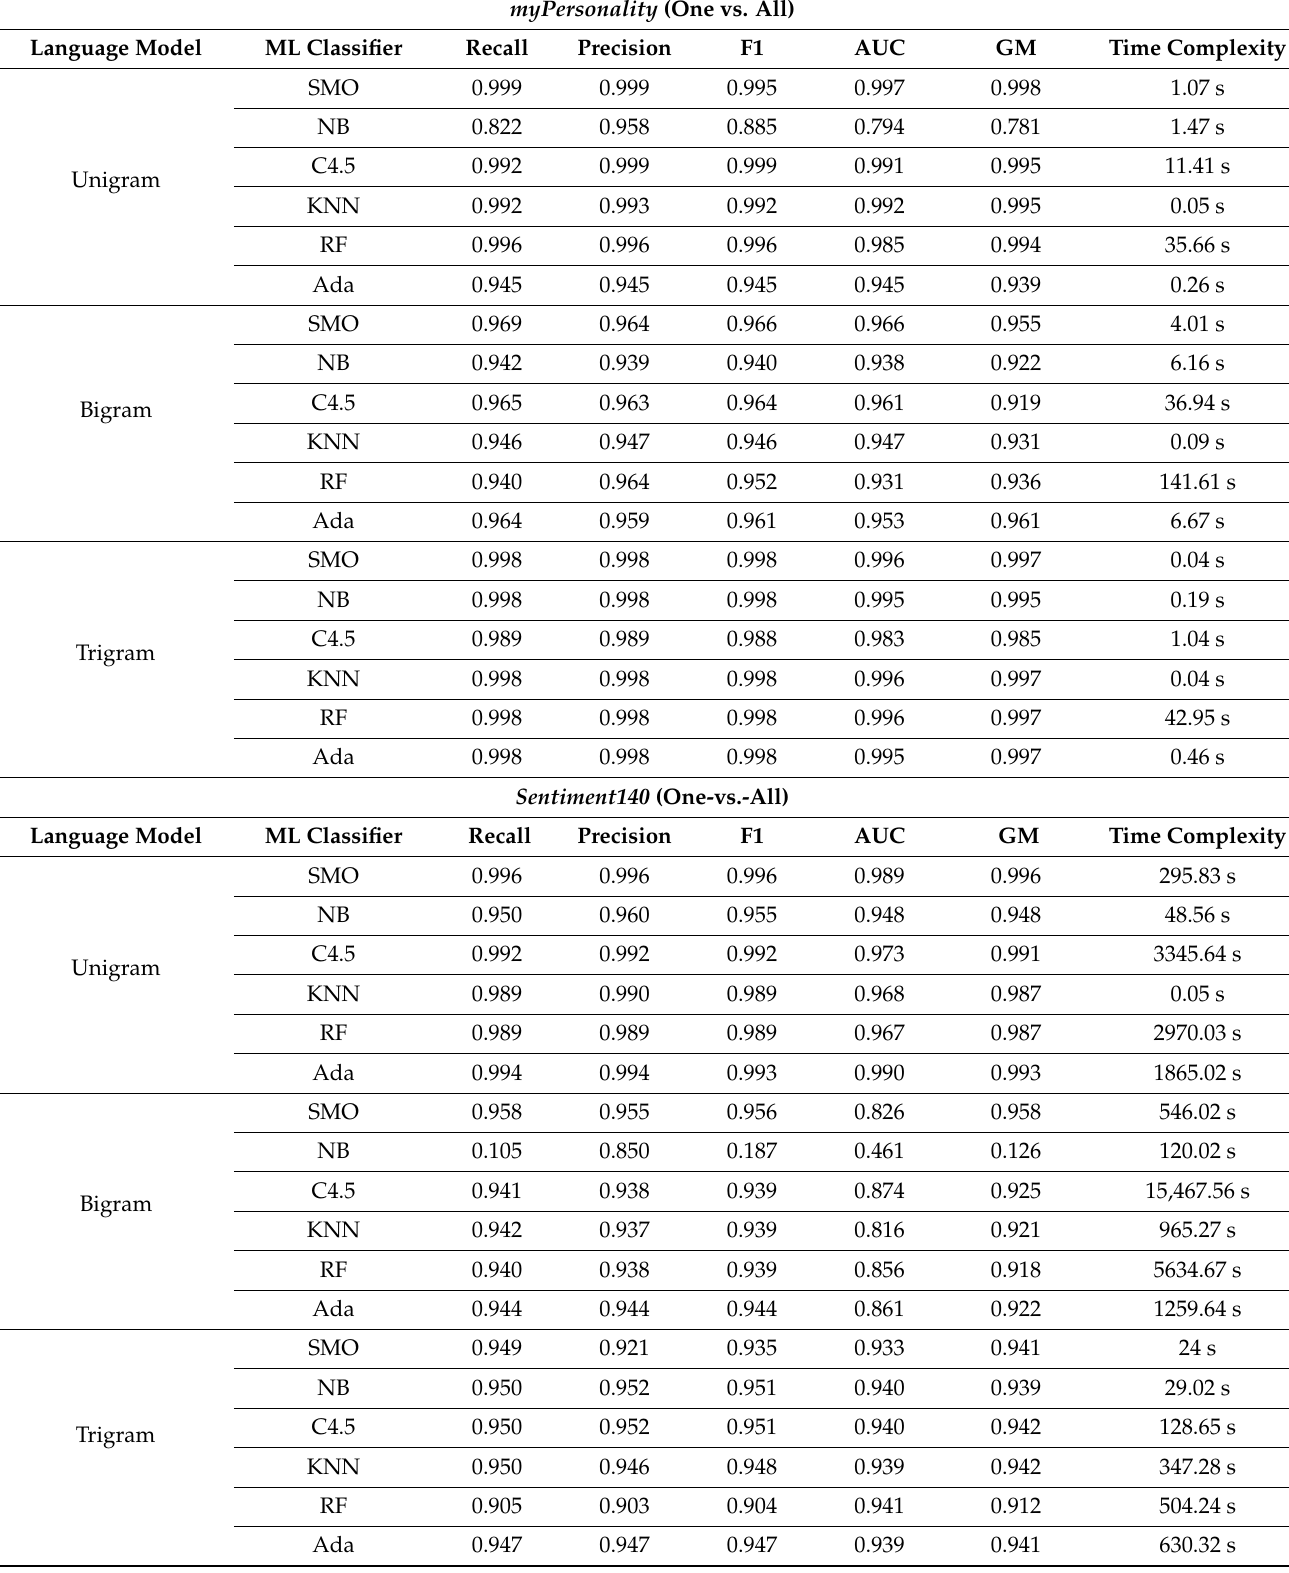
Table 10. One vs. all classification performance. myPersonality (One vs.